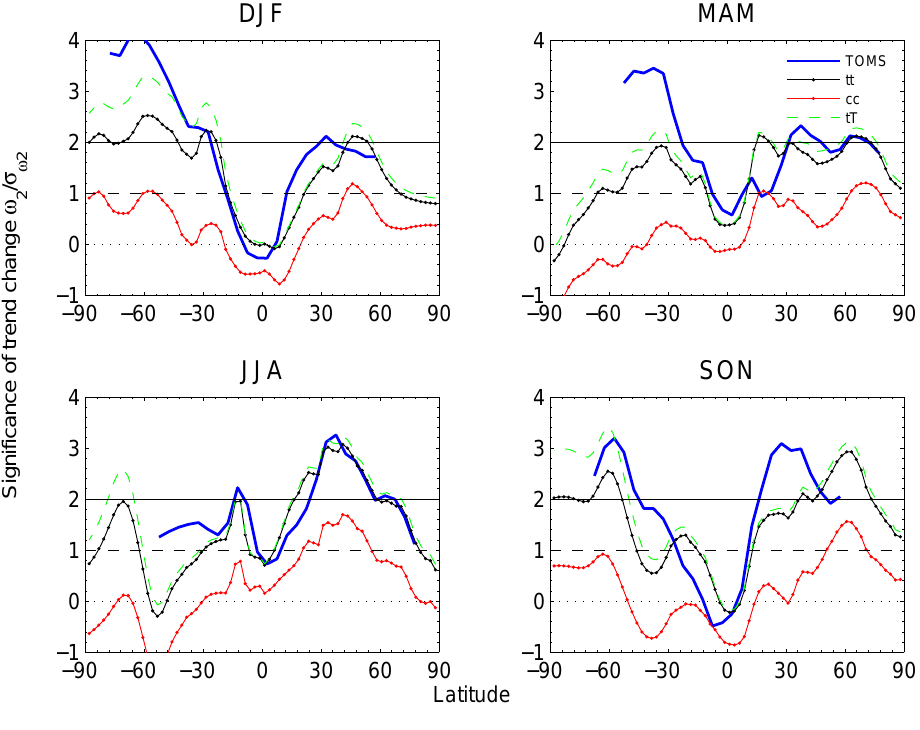
Fig. 9. Change in linear trend between the two analysis periods, 1979–1999 and 2000–2009, expressed in terms of standard deviations in order to provide a measure of its significance. Model runs with changing chemical composition ( tt , black line, and tT , green dashed line) are compared to the model run with constant chemical composition ( cc , red) and TOMS/SBUV satellite observations (blue). Contrary to Figs. 7 and 8, only the TOMS/SBUV dataset is used as a reference, in order to avoid artificial lengthening of the satellite time series in the trend-change